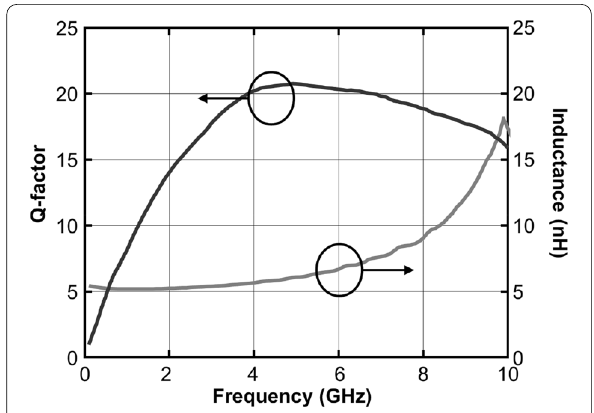
Fig. 6 Measured inductance and Q‑factor of fabricated MEMS tunable inductor at various signal